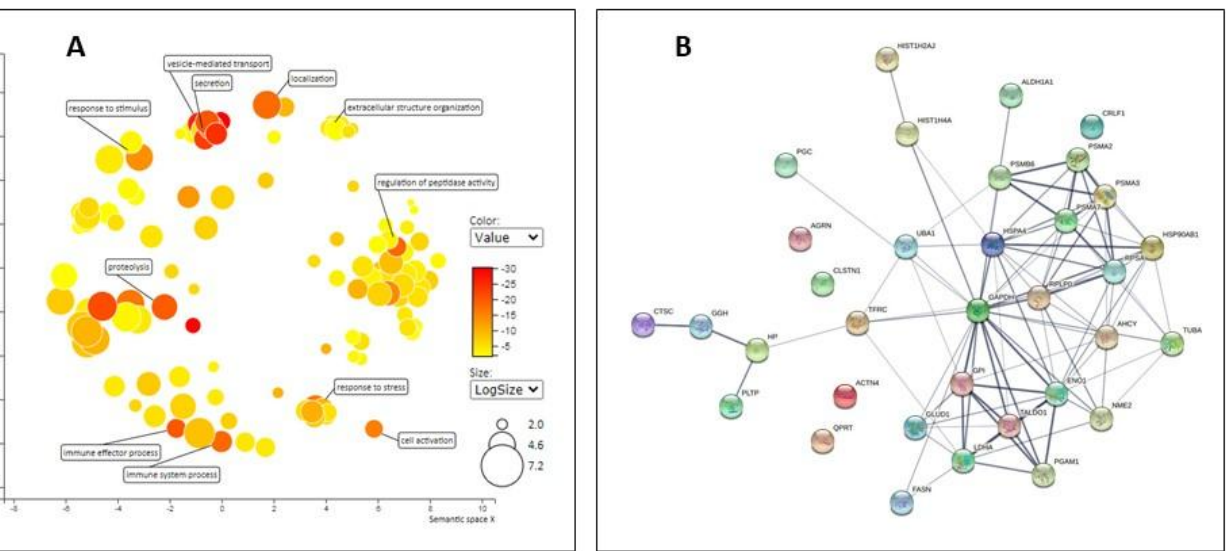
Figure 3. Bioinformatic analysis of proteins identified in EV preparations. ( A ) The enriched Gene Ontology (GO) terms that are associated to the proteins identified in EVs samples, as obtained by the gProfiler tool ( p value > 0.01) and further processed with the Revigo software ( n = 3 independent preparations). ( B ) STRING network of physical/functional interactions involving only the proteins that have a significantly different abundance in nEVs and in EVs–SB3.